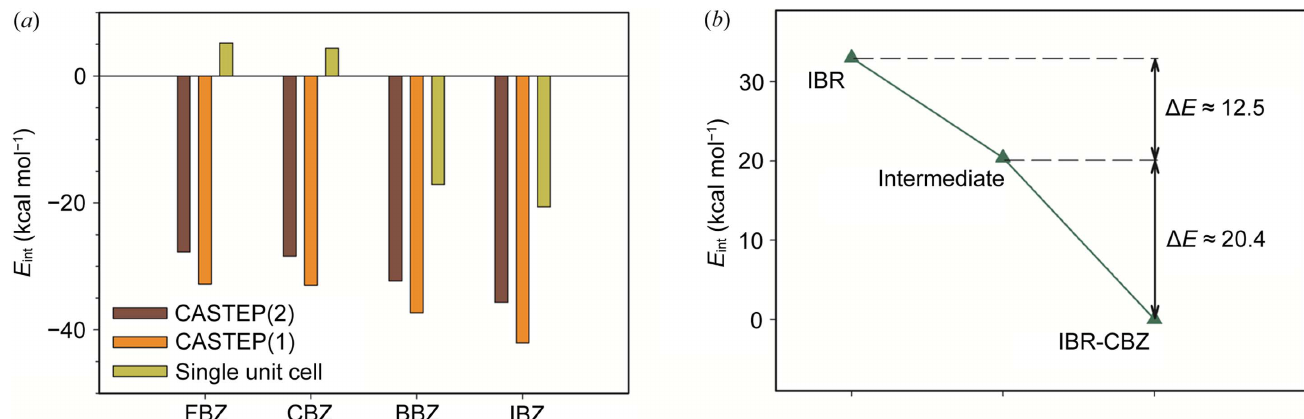
Figure 7 ( a ) E int estimated using two CASTEP -based approaches and for the isolated system. ( b ) Relative E int for the ibrutinib–CBZ solvate